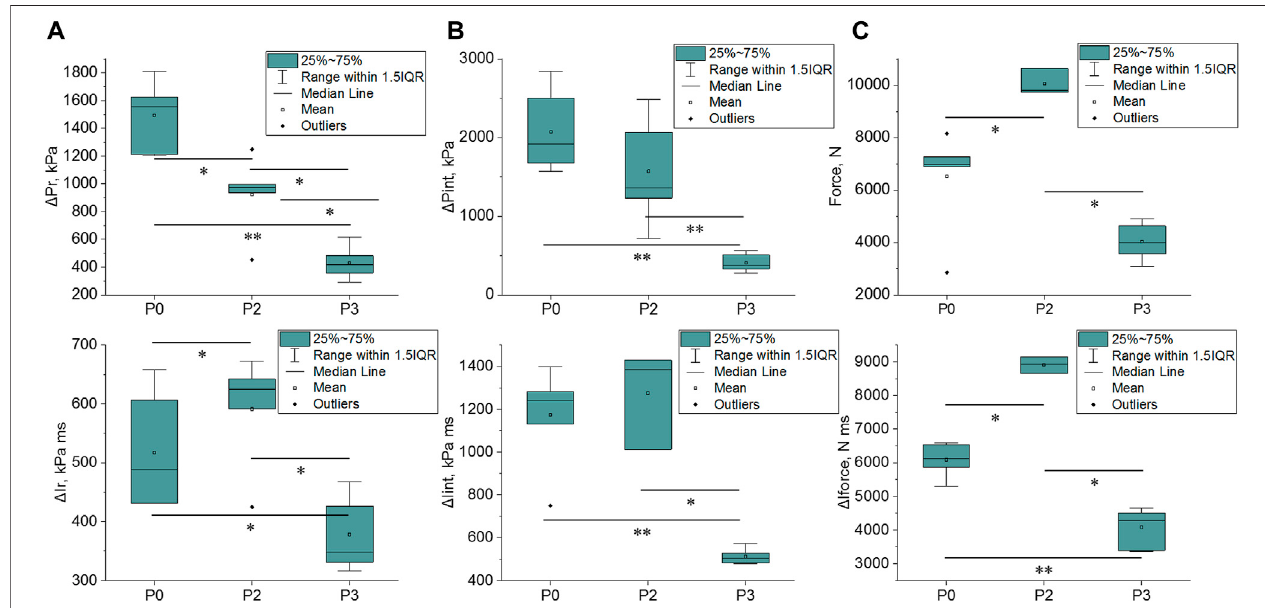
FIGURE7| EvolutionofparametersmeasuredonBOPMANregardingworeprotection(P0,P2orP3). (A) Re fl ectedoverpressure( Δ P R )andimpulse( Δ I R )data; (B) Internaloverpressure( Δ P INT )andimpulse( Δ I INT )dataand (C) theforceandcorrespondingimpulse( Δ I FORCE )data.25 ∼ 75%representsthe fi rstandthethirdquartile.IQR is the interquartile range. Median and mean values of the dataset are indicated. *: p < 0.05, **: p < 0.01, and ***: p < 0.001 (Mann-Whitney